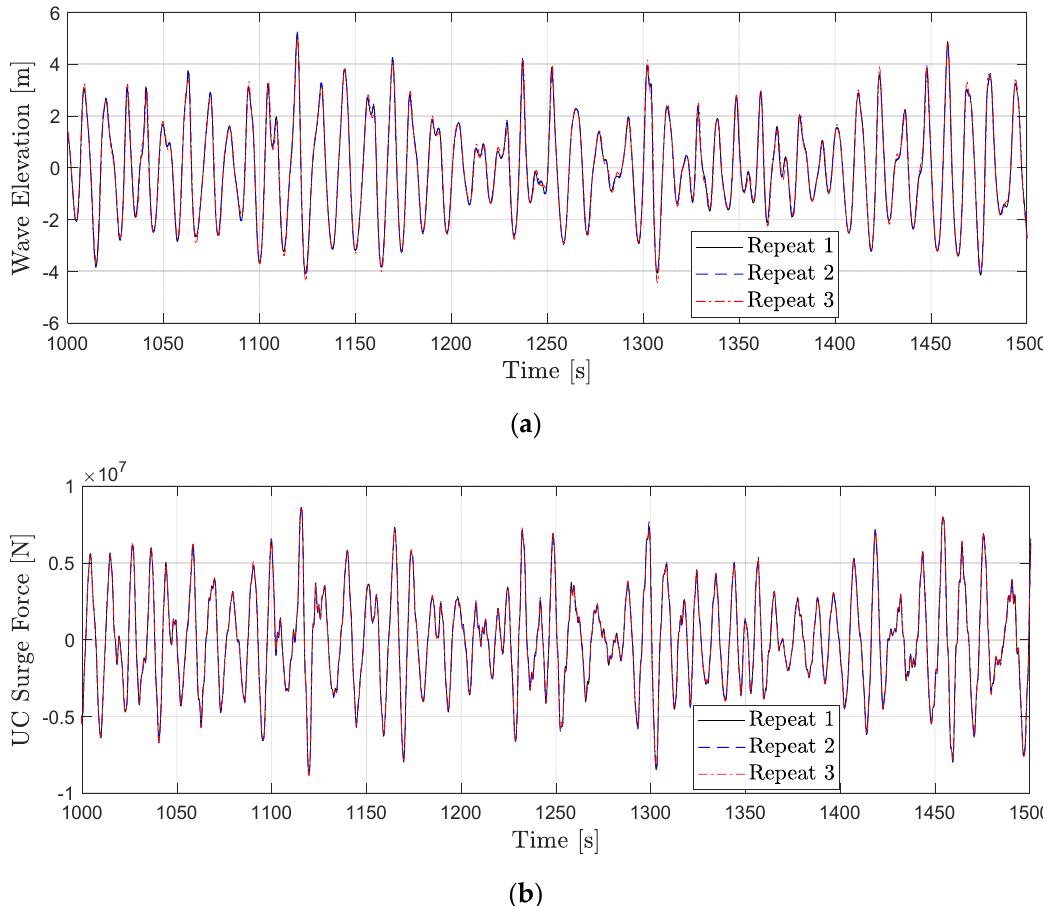
Figure 18. Repeated measurements with the irregular wave J1 of ( a ) the incident wave elevation by wave probe H during wave calibration and ( b ) the surge force on the upstream column (UC) of Configuration P, three upright columns with HP1.